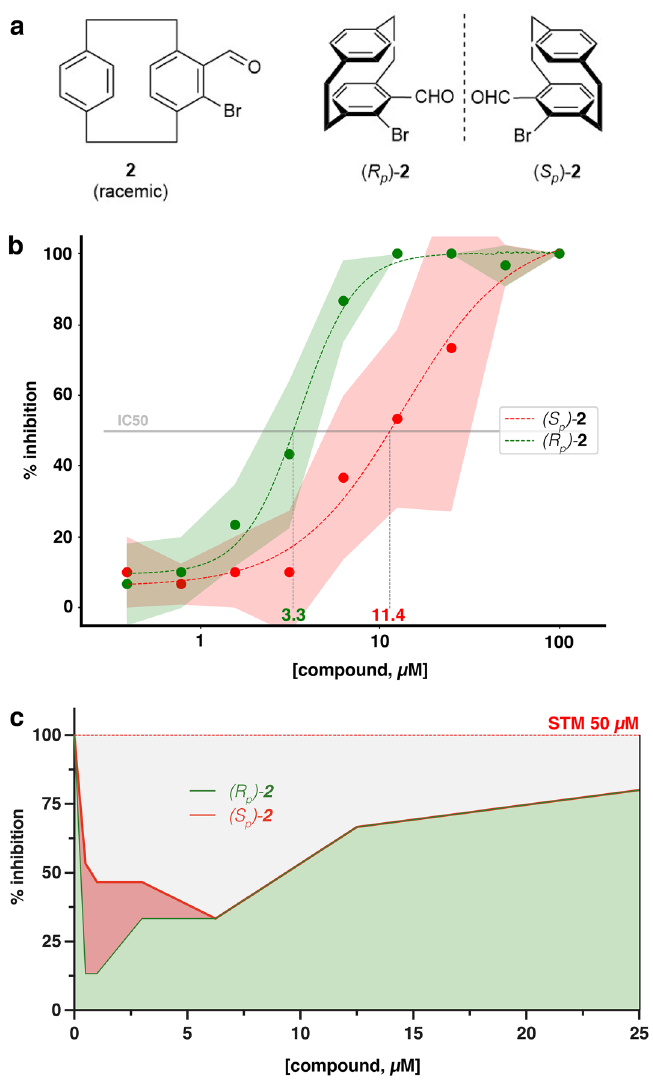
Figure 4. ( a ) Structures of racemic lead structure 2 and enantiomers ( S p )- 2 and ( R p )- 2 . ( b ) Dose–response study of the two enantiomers. Animals were treated in triplicates with the indicated concentration of the isomers for 30 min. Nematocyst discharge was recorded by counting the fraction of artemia (out of ten) caught by each polyp after 15 min. The compound concentration is shown in the log scale. Colored areas correspond to standard deviation. IC50 values were determined by fitting logistic functions to the average inhibition (dashed lines) and solving them for 50% inhibition. ( c ) Competition between compound 2 isomers and STM. Complete prey capture inhibition by 50 µM STM was partly neutralized by adding the enantiomers ( S p )- 2 and ( R p )- 2. The neutralizing effect was more pronounced in the low micromolar concentration range and stronger for ( R p )- 2. Animals were treated in triplicates with the indicated concentration of the isomers in combination with 50 µM STM for 30 min. Prey capture was recorded as in the primary screen. STM by itself completely inhibited prey capture at 50